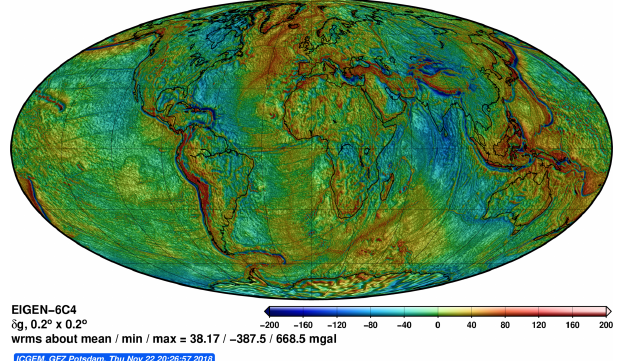
Figure 7. Gravity disturbance computed on the Earth’s surface from the EIGEN-6C4 combined gravity field model expanded up to a degree and order of